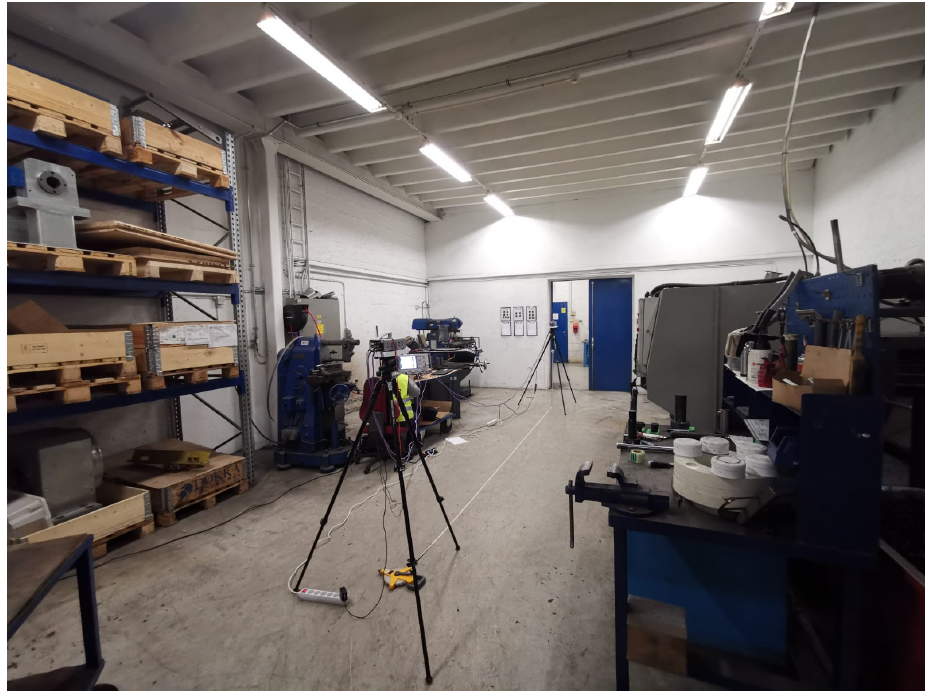
Figure 3. Measurement setup in the Test room at Dokka Fasteners AS. Two big metallic machines are located on the right side. Metallic shelves with may pieces of heavy-duty equipment inside the wooden boxes and two metallic machines on the left side.